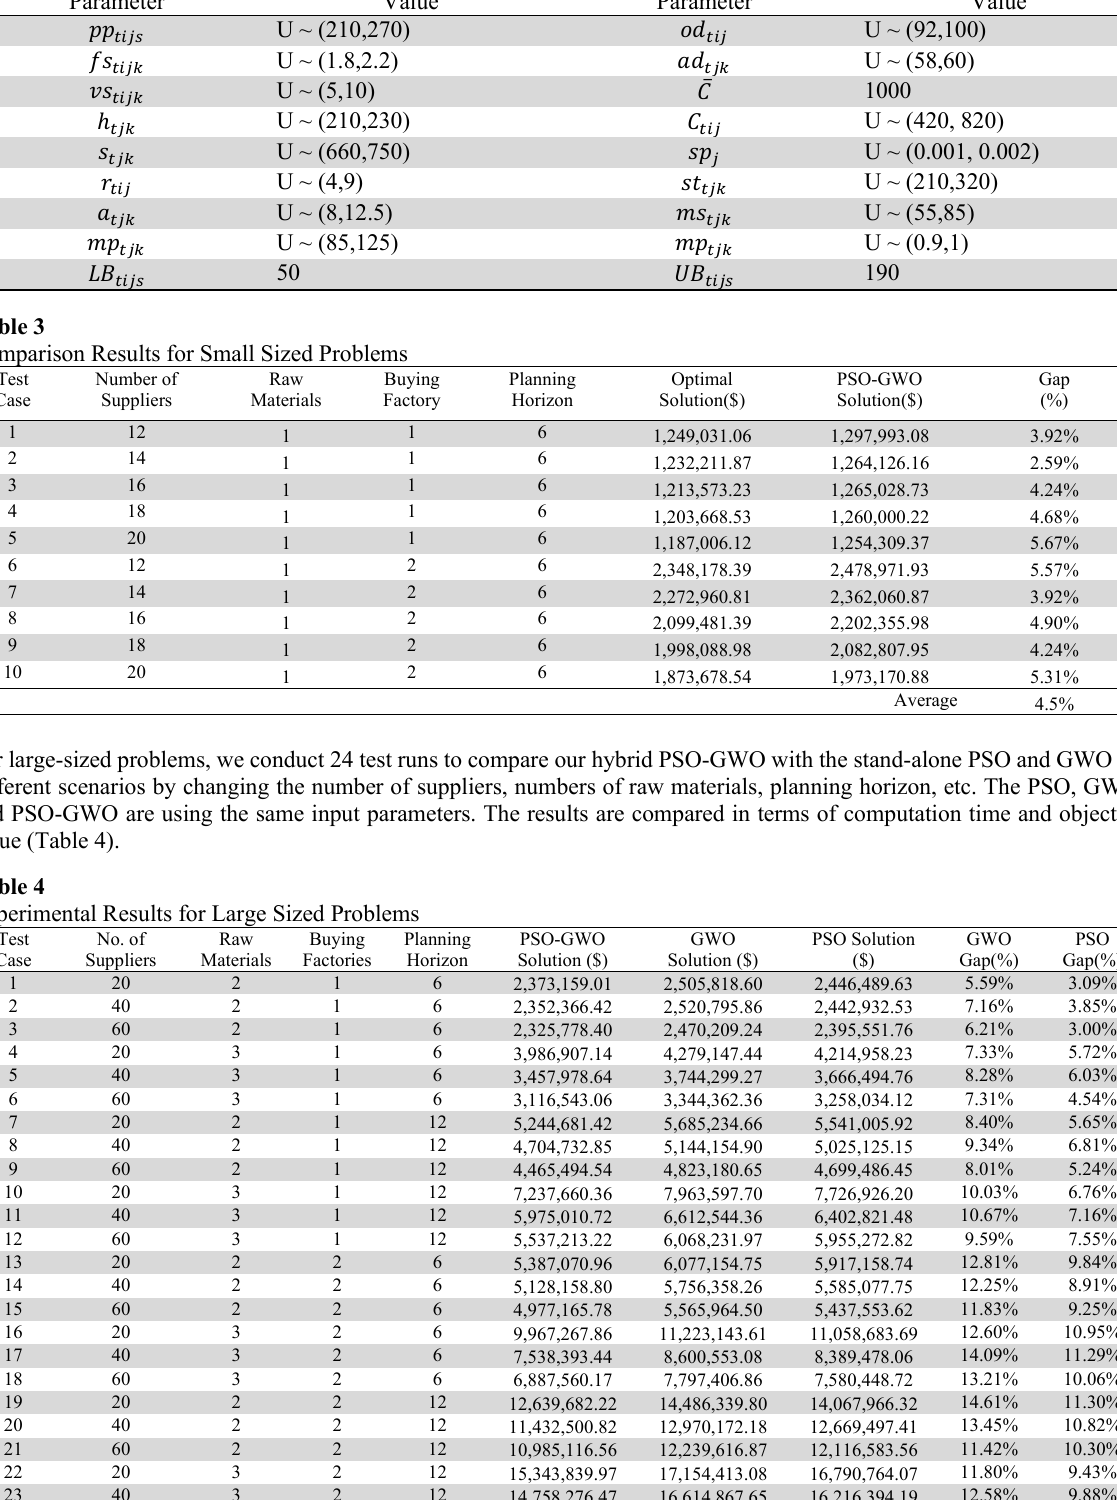
Testing Parameters Parameter